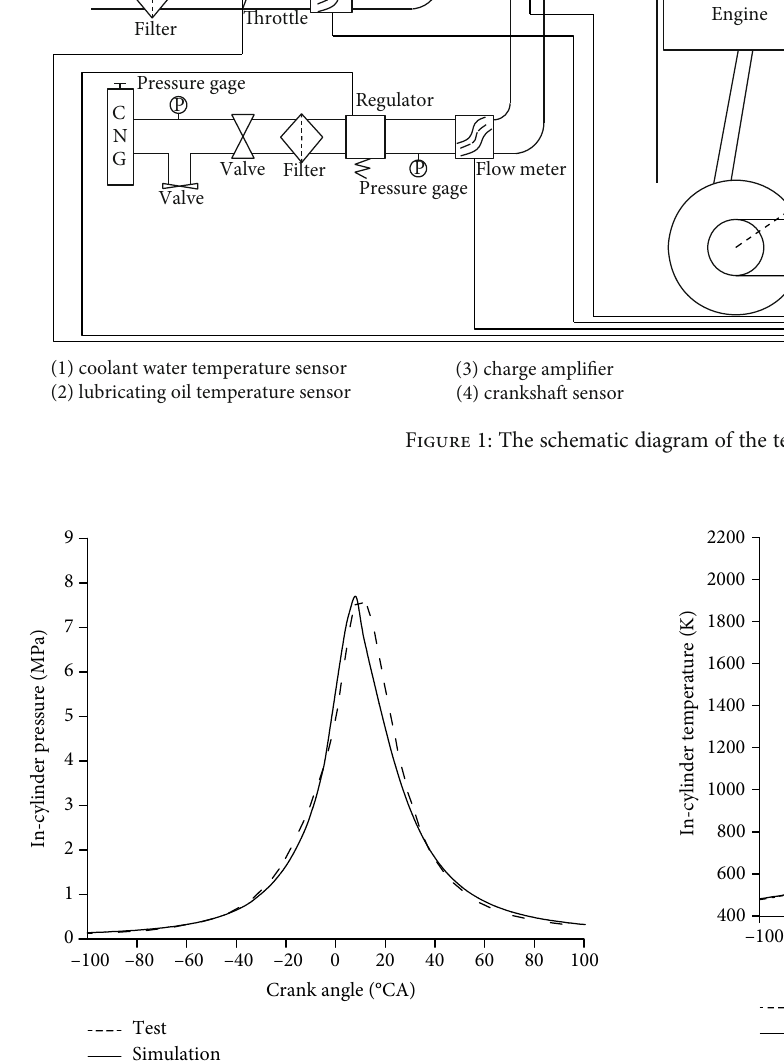
Figure 3: Comparison between simulated and measured